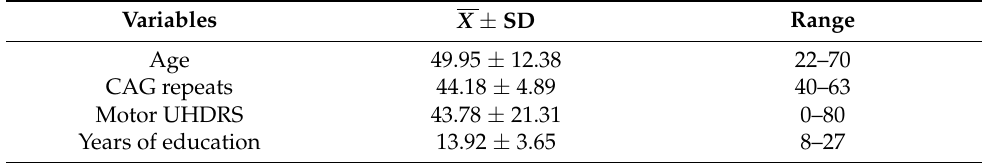
Table 1. Characteristics of the study group of HD patients in whom plasma BDNF levels were